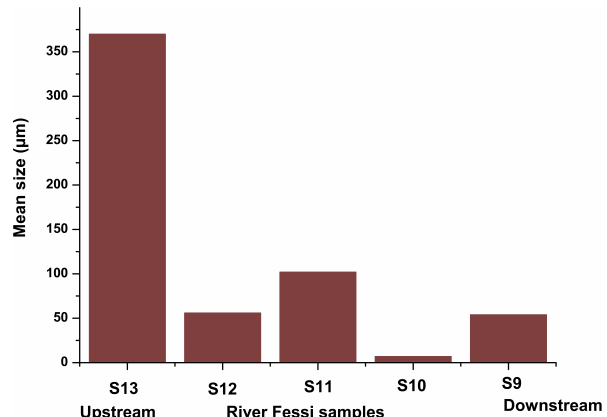
Figure 6. Distribution of the mean size of the samples collected in the Fessi